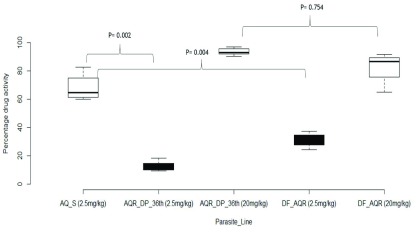
Stability of the amodiaquine resistant line.Percentage activity of the amodiaquine against the drug-sensitive parent line (AQ_S), the 36
th passage AQ resistant line (AQR_36
th) and the drug-free AQ resistant line (DF_AQR). The AQ_S parasite line remained susceptible to AQ at 2.5mg/kg but both the AQR_36
th and DF_AQR parasite line retained the resistance level as portrayed by the responses to both 2.5mg/kg and 20mg/kg of AQ. The 90% effective dosage for AQ_S, AQR_36
th and DF_AQR was 4.29mg/kg, 19.13mg/kg, 20.34mg/kg respectively.